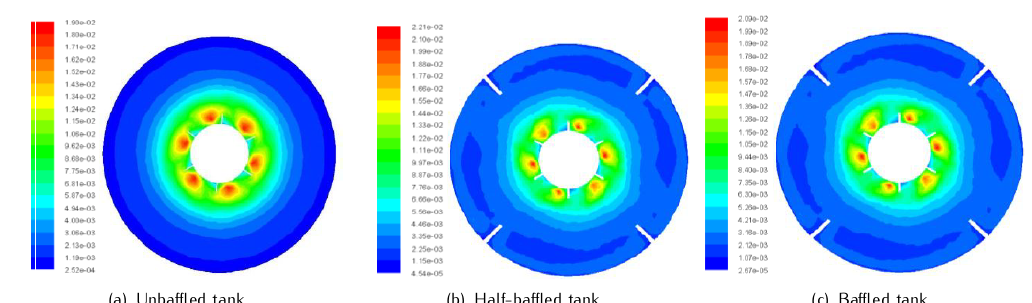
Figure 8. Distribution of the turbulent kinetic energy in the r- θ plane.